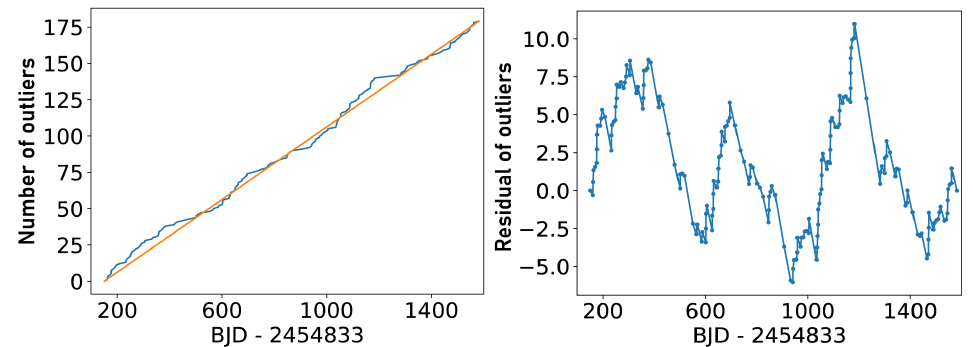
Figure 3. The left panel shows the total sum of the number of outliers vs. time for the observed light curve (blue) and an ideal line (orange) for detected magnetic activity during each observation. The line (orange) represents the uniform detection of magnetic activity. The right panel depicts the residuals from the line and the observed curve shown on the left. KIC 9017220 is taken as an